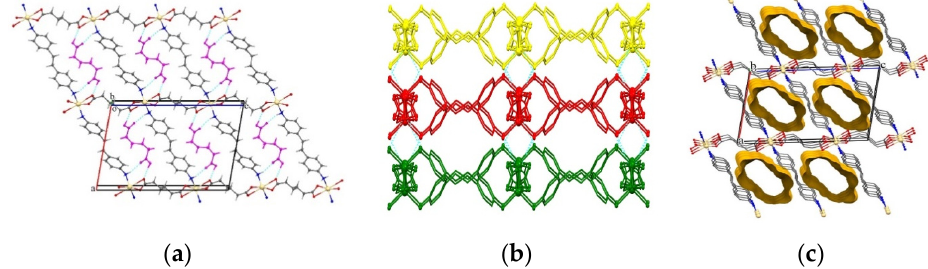
Figure 7. Compound 7 . ( a ) Fragment of 2D grid with H-bonded H 2 adi shown in magenta color. ( b ) Stacking of coordination layers. ( c ) Crystal packing with voids shown in yellow.